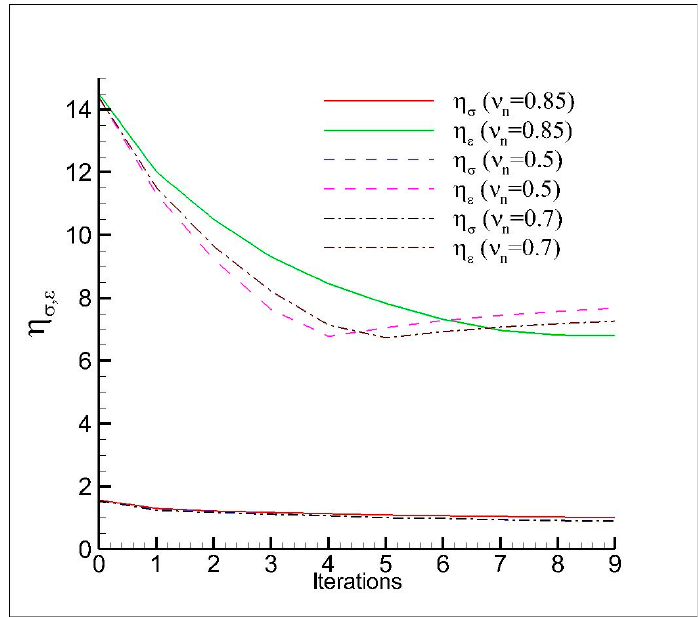
Figure 11. Convergence history— ϕ values for: ( a ) Local Model 1, ( b ) Local Model 2, ( c ) Local Model